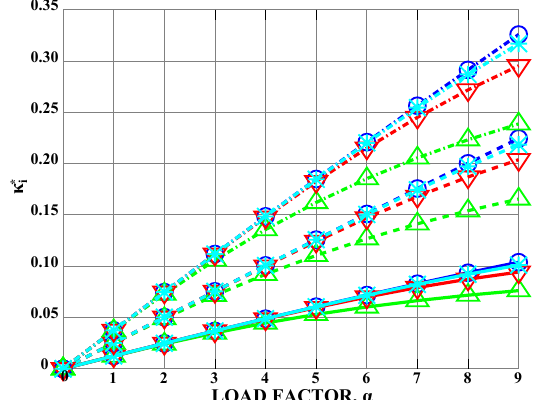
(solid line), κ ∗ 1 2